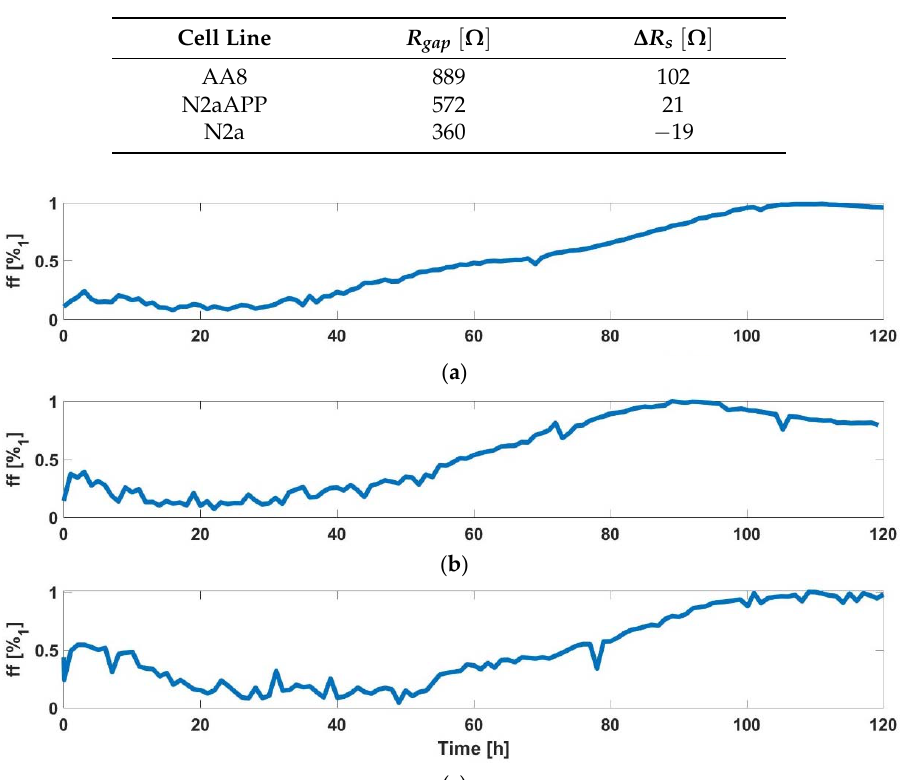
Figure 5. Estimated ff for: ( a ) AA8 cell line model, ( b ) N2aAPP cell line model and ( c ) N2A cell line model.